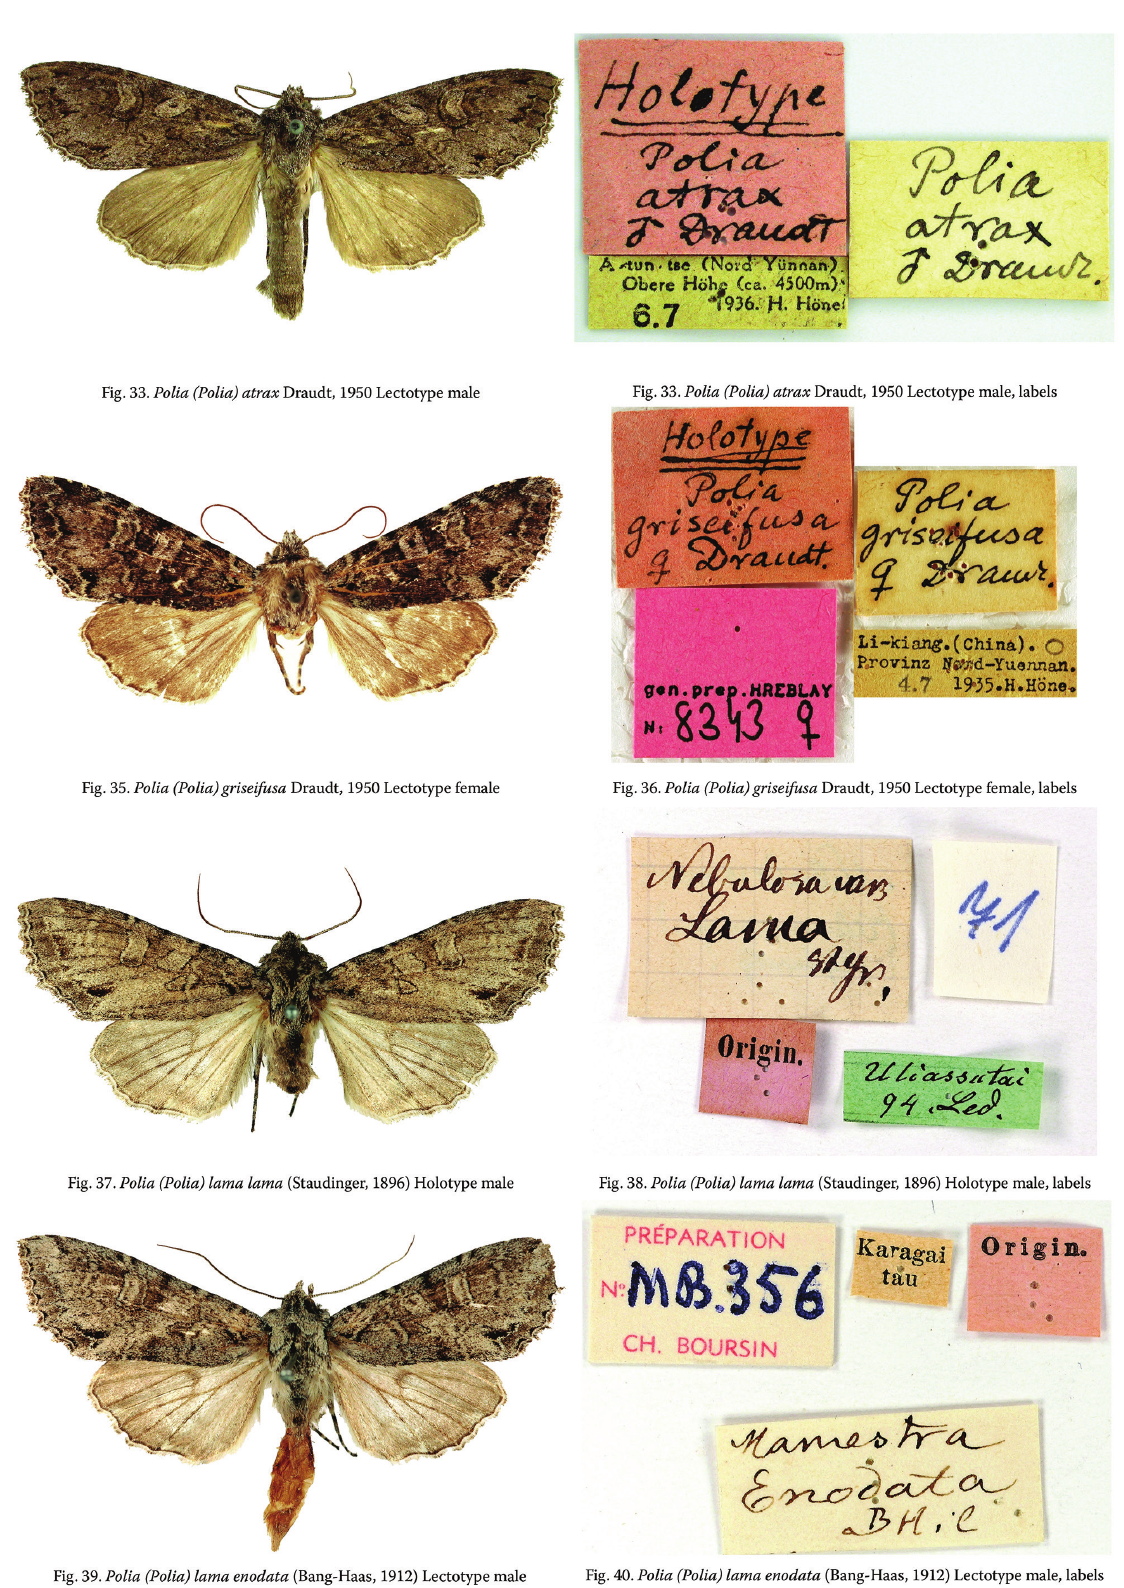
Figure 33–40. 33. Polia ( Polia ) atrax Draudt, 1950 Lectotype male. 34. Polia ( Polia ) atrax Draudt, 1950 Lectotype male, labels. 35. Polia ( Polia ) griseifusa Draudt, 1950 Lectotype female. 36. Polia ( Polia ) griseifusa Draudt, 1950 Lectotype female, labels. 37. Polia ( Polia ) lama lama (Staudinger, 1896) Holotype male. 38. Polia ( Polia ) lama lama (Staudinger, 1896) Holotype male, labels. 39. Polia ( Polia ) lama enodata (Bang-Haas, 1912) Lectotype male. 40. Polia ( Polia ) lama enodata (Bang-Haas, 1912) Lectotype male,